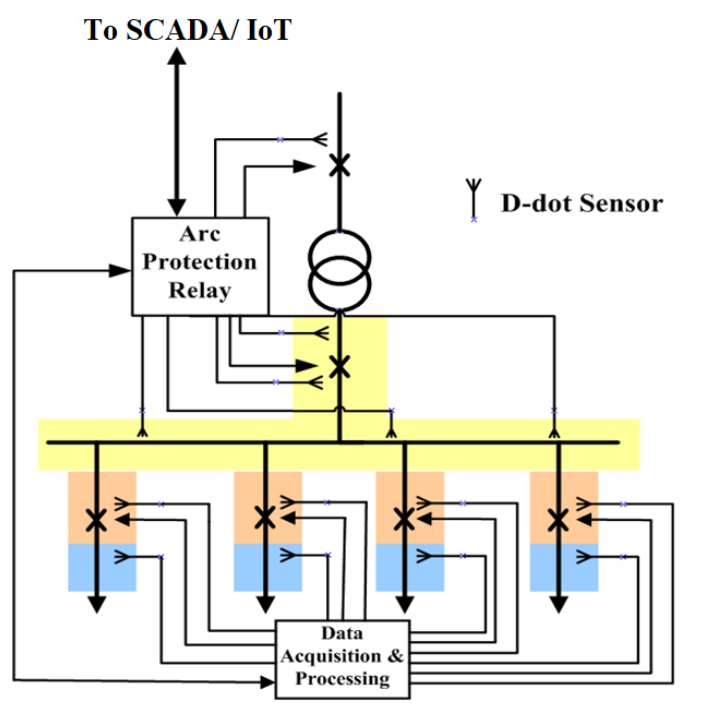
Figure 18. Outline of online monitoring system integrated with